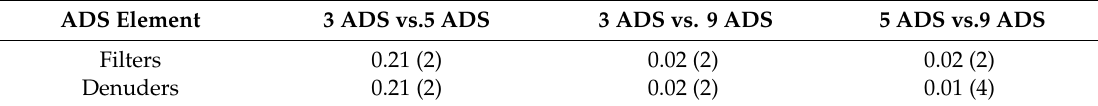
Table 5. Statistical Analysis comparing the Chloride aerosol percent concentrations per system element of the three ADS set-ups. The p -values for the t -tests for unequal variances, two-tailed, and the 95% confidence interval are shown. The degrees of freedom are shown in